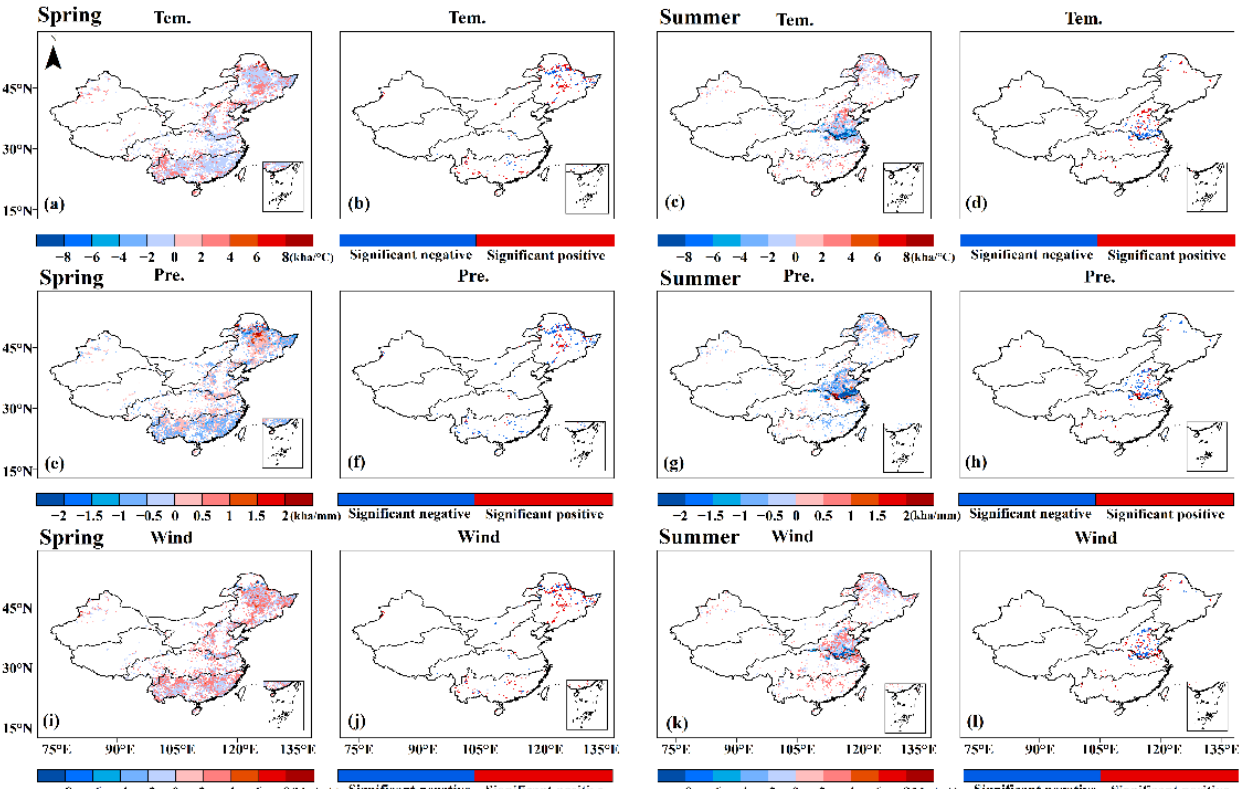
Figure 12. The coefficients of the multivariable regression equations between BA and three climatic factors (i.e., temperature, precipitation and wind speed) in spring and summer. The first and third columns show all points in spring and summer, respectively, and the second and fourth columns show the corresponding significant points ( p < 0.1) in spring and summer, respectively: ( a – d ) represent temperature; ( e – h ) represent precipitation; ( i – l ) represent wind.